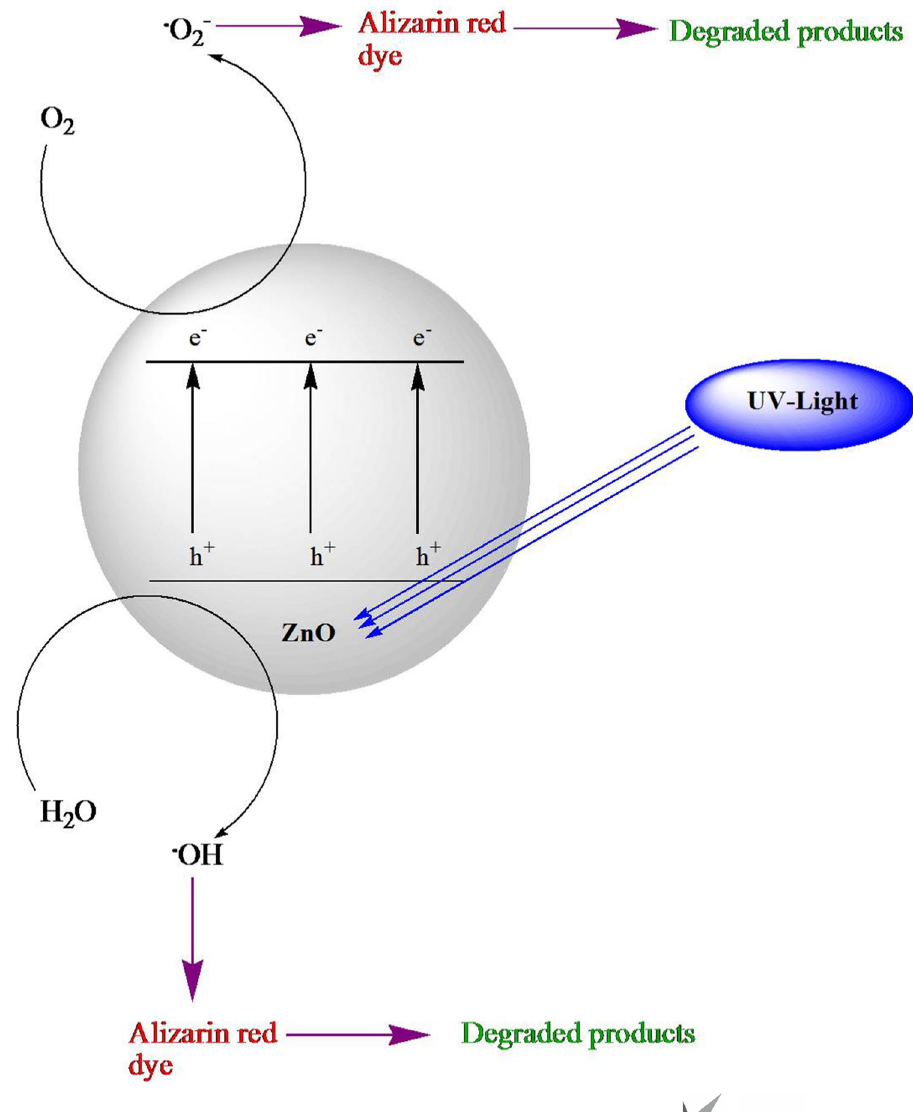
Fig. 9 Proposed mechanism for the photodegradation of AR dye photodegraded by